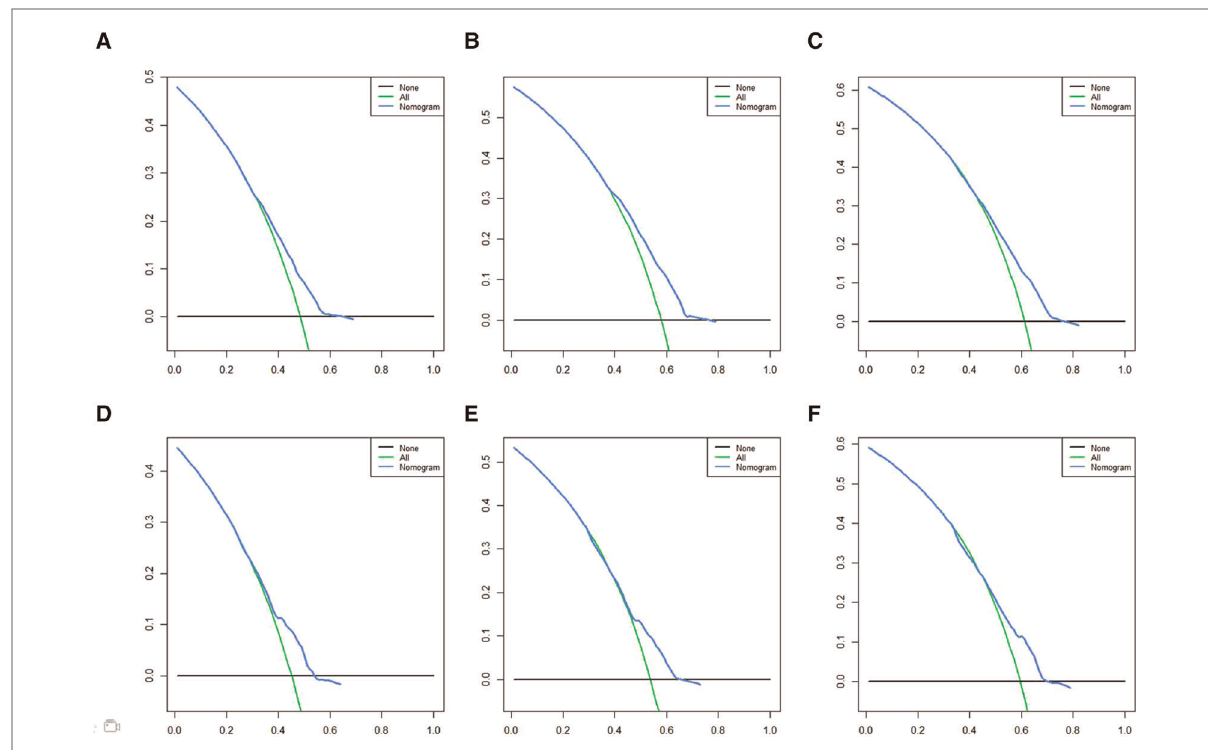
FIGURE 6 DCA for CSS prediction. ( A ) DCA of 3-years CSS in the training cohort, ( B ) DCA of 5-years CSS in the training cohort, ( C ) DCA of 7-years CSS in the training cohort, ( D ) DCA of 3-years CSS in the validation cohort, ( E ) DCA of 5-years CSS in the validation cohort, ( F ) DCA of 7-years CSS in the validation cohort. DCA, Decision curve analysis; CSS, cancer-speci fi c survival.